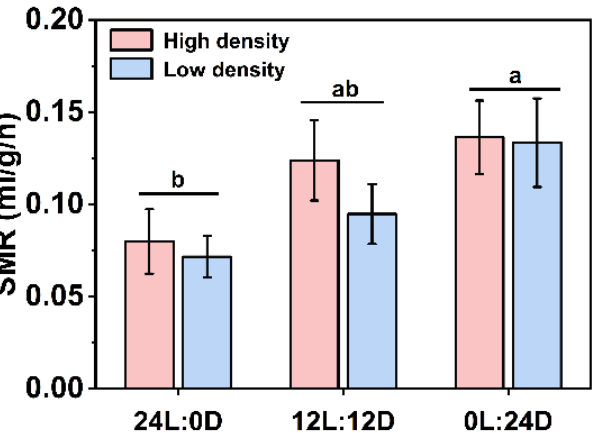
Figure 4. Effects of photoperiod and density on the SMR of Pelodiscus sinensis . Data are n = 12 for all groups. Data are presented as mean ± S.E.; different lowercase letters indicate a significant difference among different photoperiods ( p < 0.05).